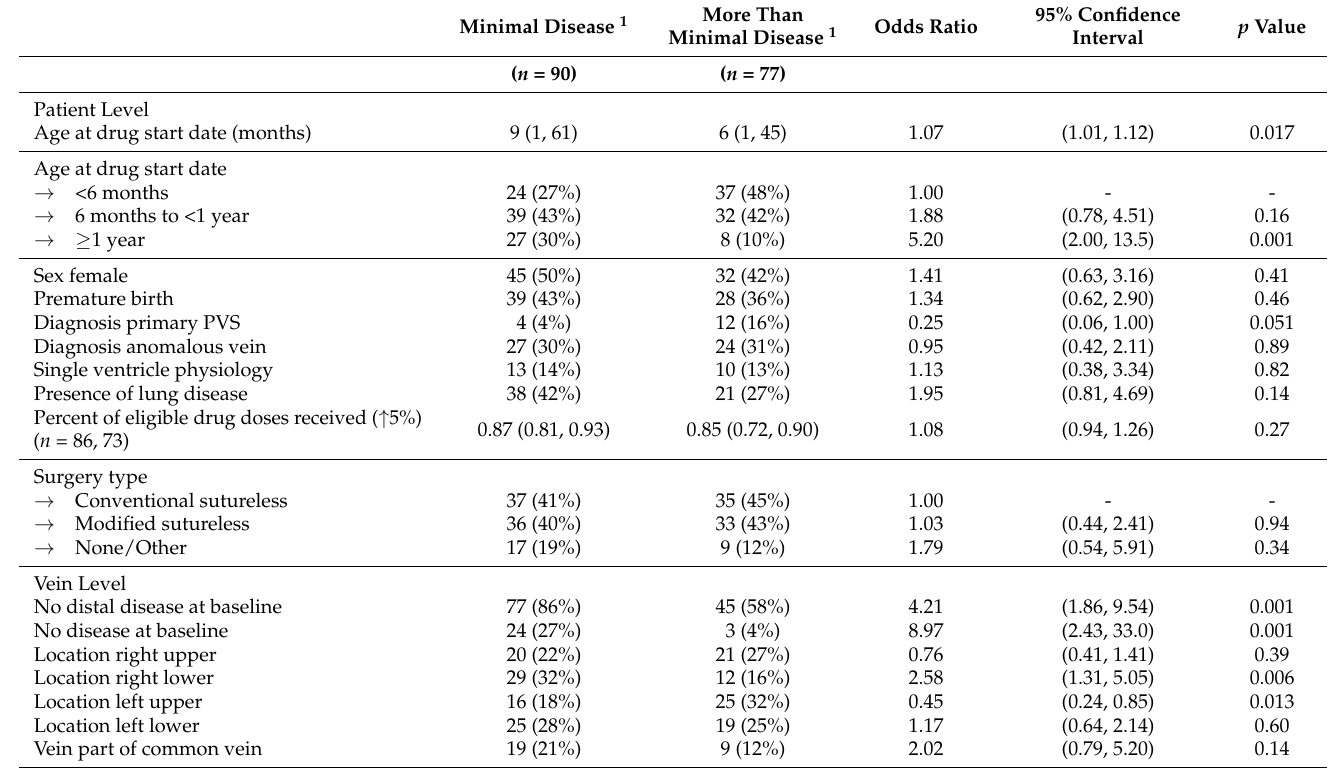
Table 4. Vein status at study endpoint, by patient, and vessel characteristics: univariate analysis for the outcome of minimal disease.